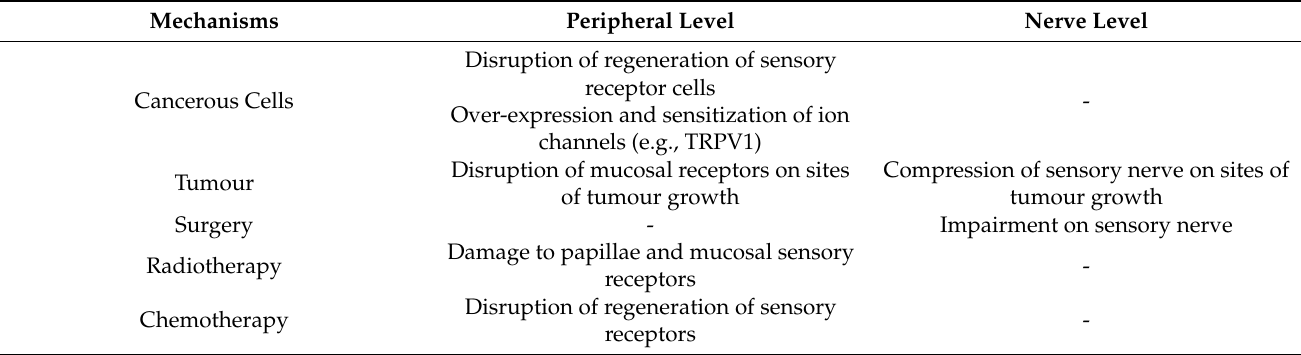
Table 2. Overview of mechanisms in which cancer and its treatments alter oral